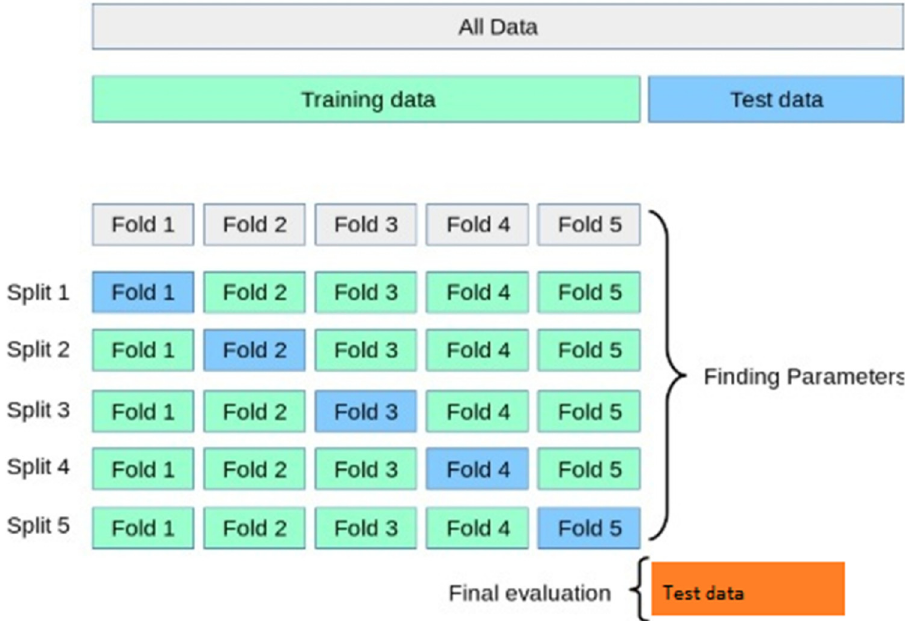
Figure 11: K - fold methods.